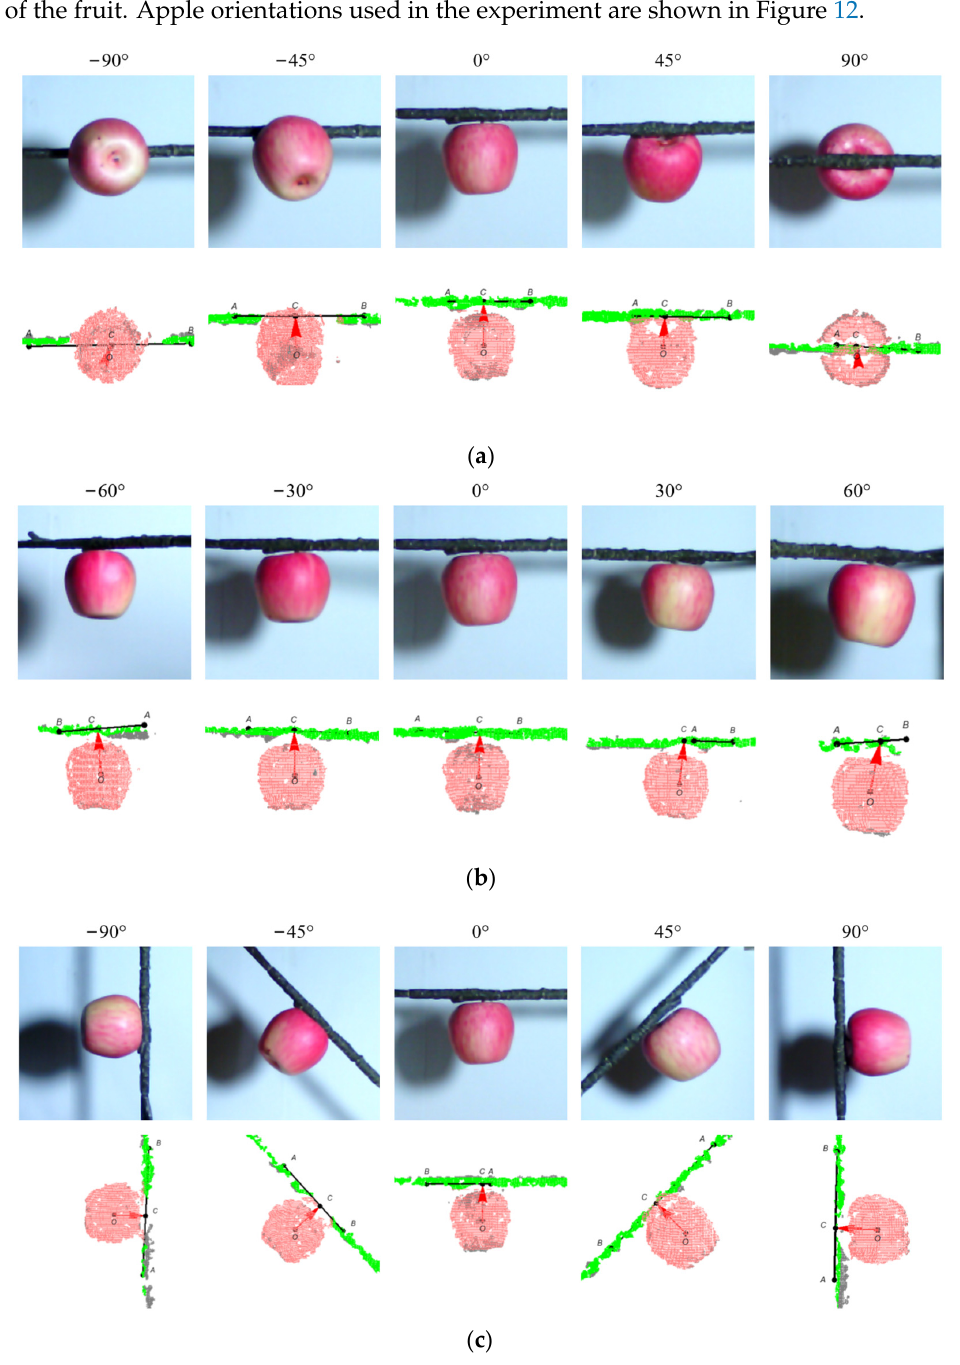
Figure 12. ( a ) Rotate through − 90°, − 45°, 0°, 45°, and 90° around the x axis. ( b ) Rotate through − 60°, − 30°, 0°, 30°, and 60° around the y axis. ( c ) Rotate through − 90°, − 45°, 0°, 45°, and 90° around the z axis.